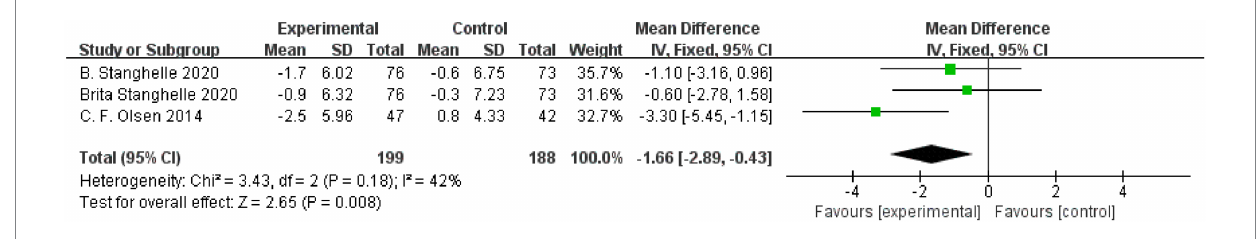
FIGURE 8 Forest plot for the falls efficacy scale international (FES-I).